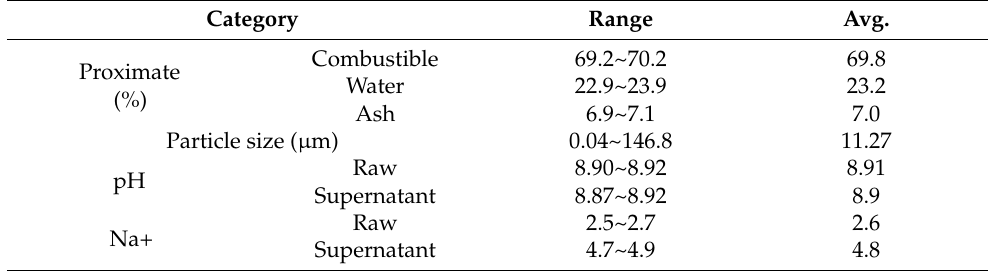
Table 1. Characteristics of